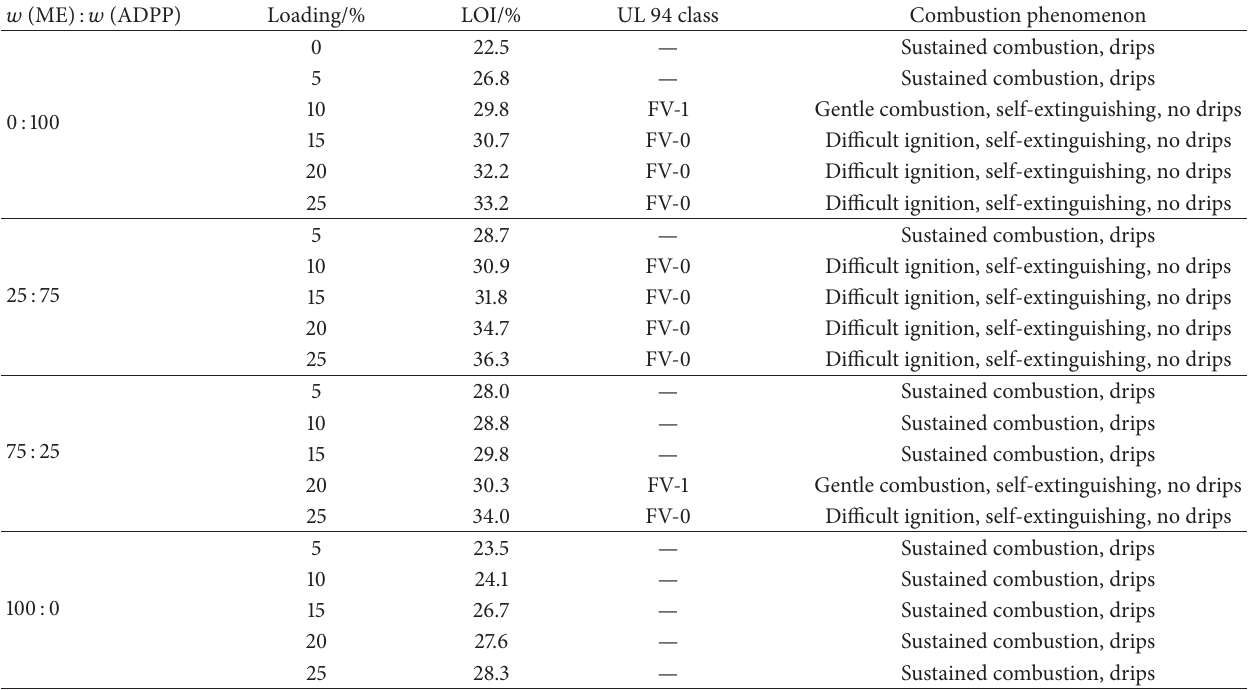
Table 2: Effect of the loading of flame retardants on its flame retardance in